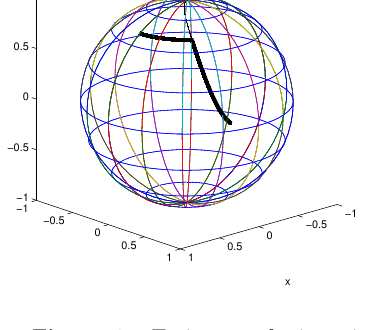
Figure 9. In recoiling models the orientation jumps from p ∗ to p ∗∗